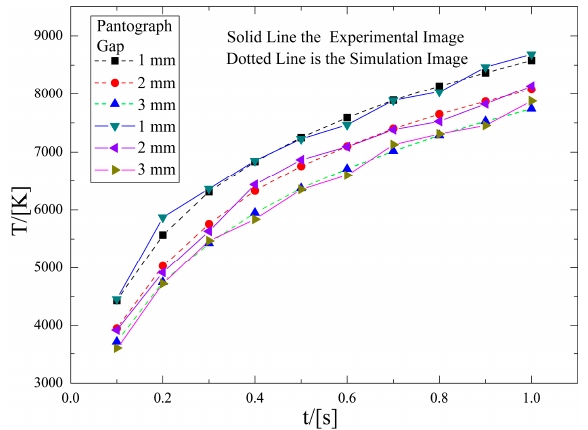
Figure 10. Arc temperature and time variation